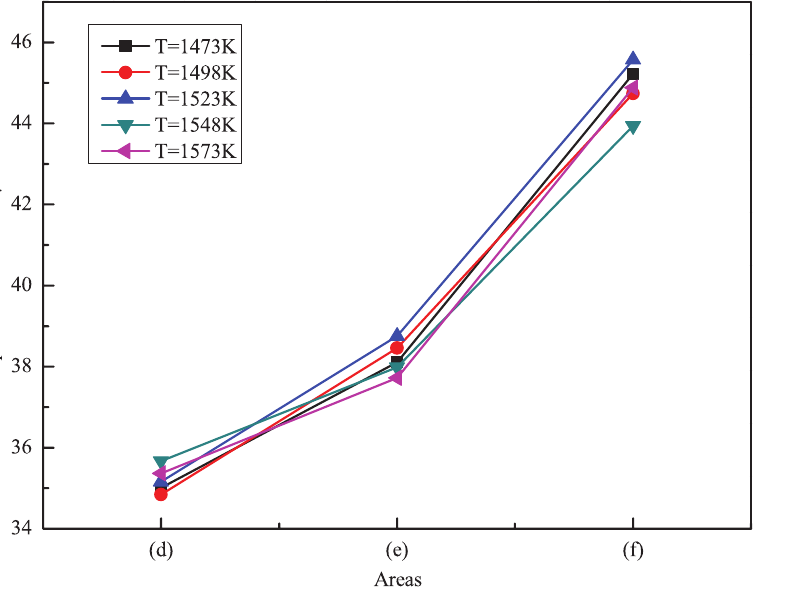
Fig. 8: Variations of equivalent diameters of V-containing spinel phase in different areas of the samples with different temperature at G = 1050, t = 30